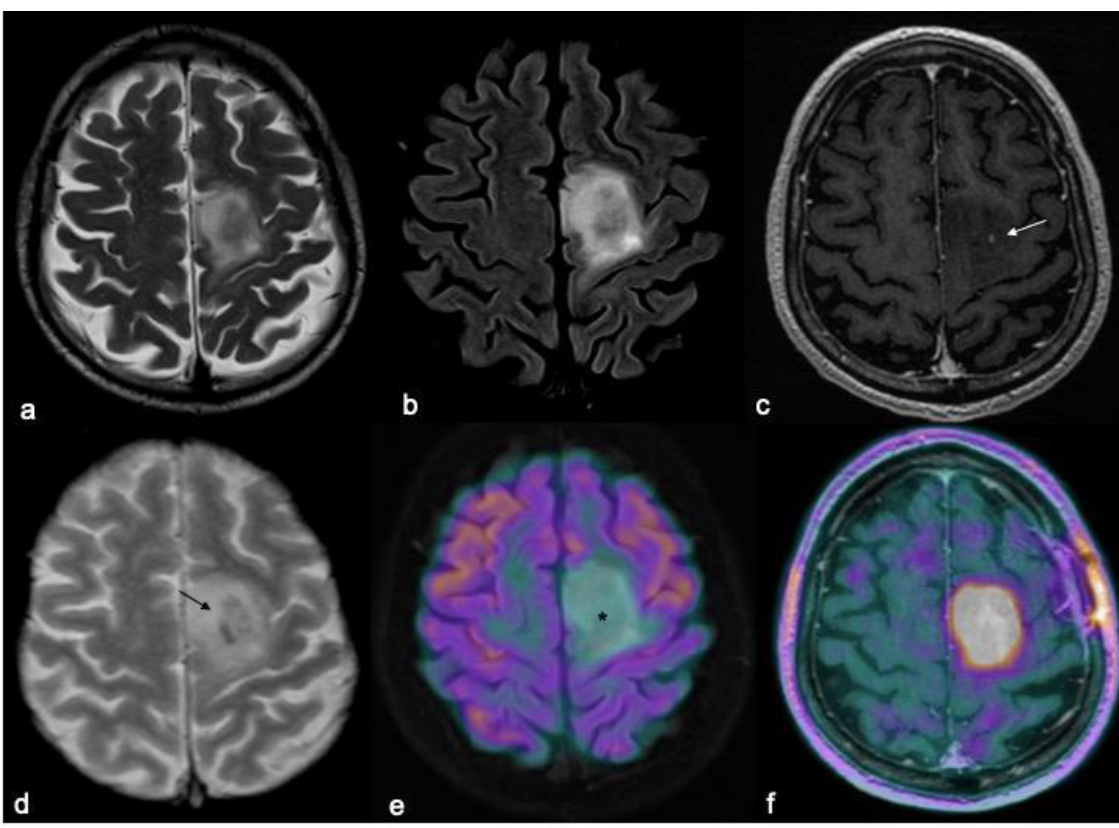
Figure 3. MRI and PET characteristics of a diffuse IDH-MUT 1p/19q codeleted glioma (oligoden- droglioma grade 2). T2w fast spin echo ( a ), T2w FLAIR ( b ), T1w fast spin echo contrast-enhanced ( c ), T2*-weighted gradient echo ( d ), FDG-PET/MRI ( e ), and DOPA-PET/MRI ( f ) images are shown. Mesial frontal mass with a low mass effect and without any significant enhancements after contrast (arrow in ( c ) indicates the only spot of blood – brain barrier leakage), and some intratumoral calcifi- cations (arrow in ( d ); CT not shown) with no significant radiotracer uptake by FDG-PET (asterisk in ( e )), but showing a lively uptake of the PET-DOPA radiotracer ( f ).